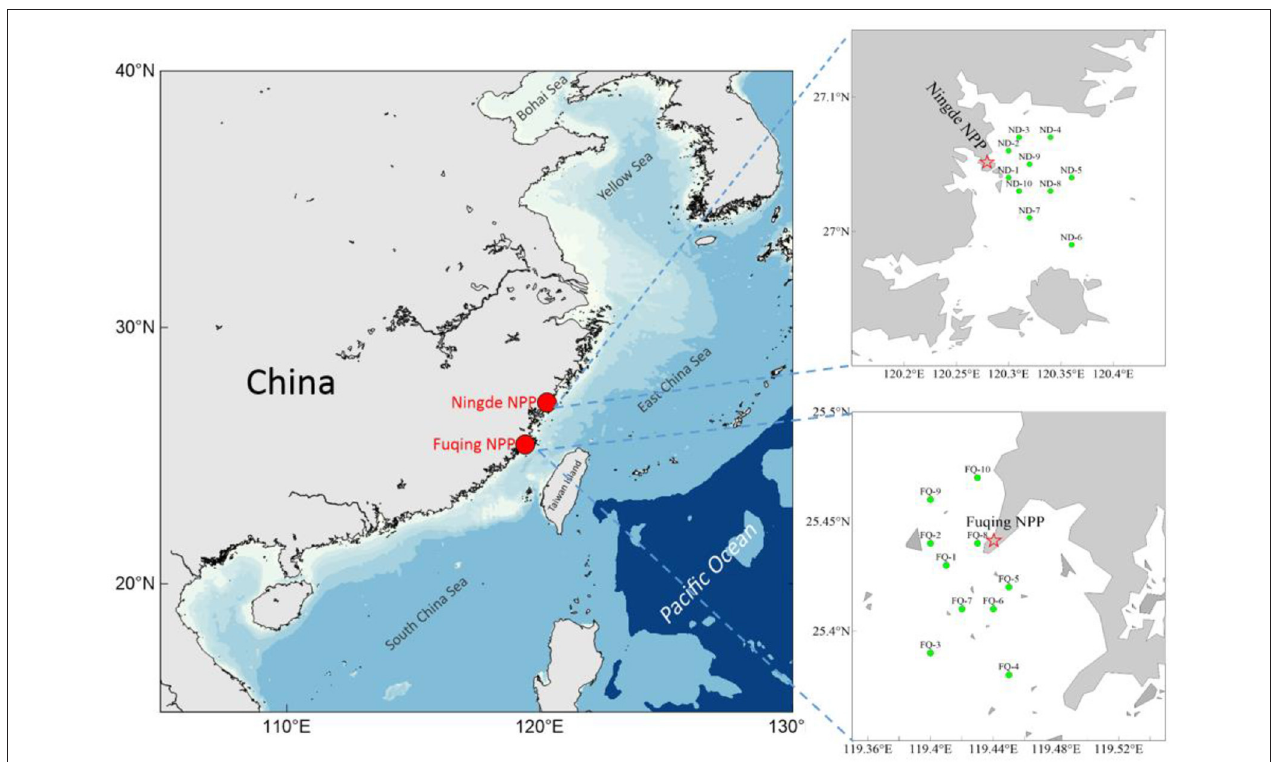
FIGURE 1 | Sediment and water sampling stations (green symbols) near the Fuqing and Ningde nuclear power plants along the coast of